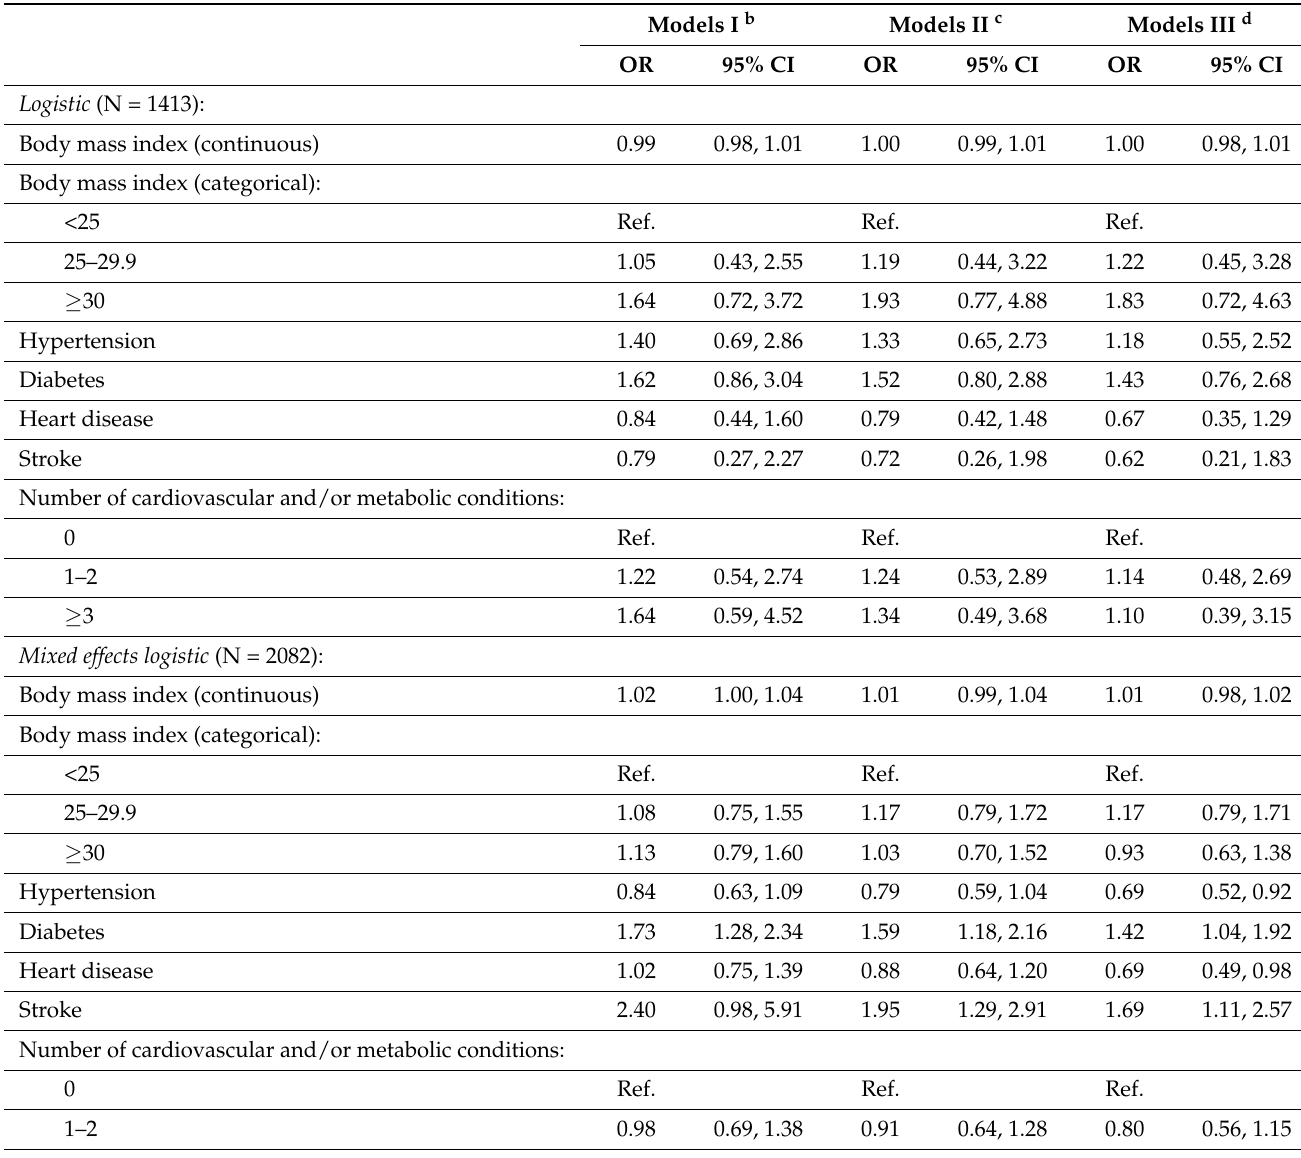
Table 3. Logistic regression models for cardiovascular and/or metabolic conditions as predictors of surgical delays–HRS COVID-19 half-sample a